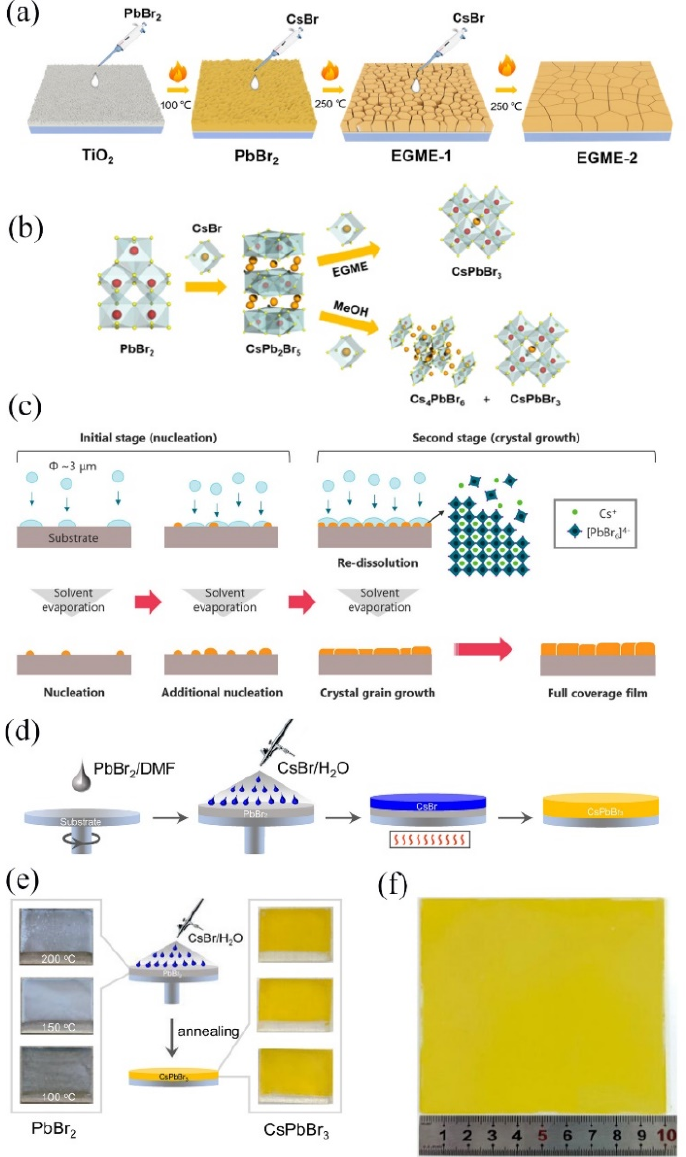
Figure 3. ( a ) Schematic diagram of the triple-step solution method for the fabrication process of CsPbBr 3 films and ( b ) schematic illustration of the phase conversion process of Cs-Pb-Br films through various bi-solvent solutions. Reproduced with permission [93]. Copyright 2022, Elsevier Inc. Publications. ( c ) Schematic diagram of the mist deposition method for full-coverage CsPbBr 3 [79]. Copyright 2020, American Chemical Society Publications. ( d ) Schematic illustration of water-based spray-assisted method for scalable CsPbBr 3 film. ( e ) Photographs of CsPbBr 3 films by spray-assisted method with the thermal treatment temperature for PbBr 2 at 100 °C, 150 °C, and 200 °C. ( f ) Photograph of CsPbBr 3 film with the area up to 10 × 10 cm 2 [80]. Copyright 2021, Elsevier Inc. Publications.